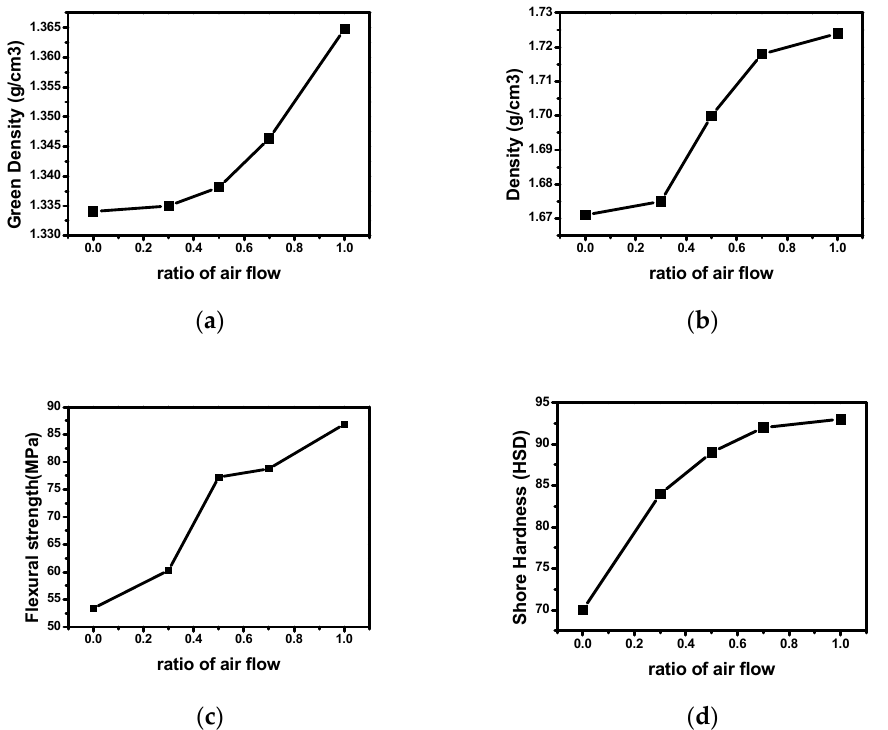
Figure 5. Mechanical properties of carbon blocks according to ratio of air flow ( a ) green density, ( b ) density after carbonization, ( c ) flexural strength, ( d ) shore